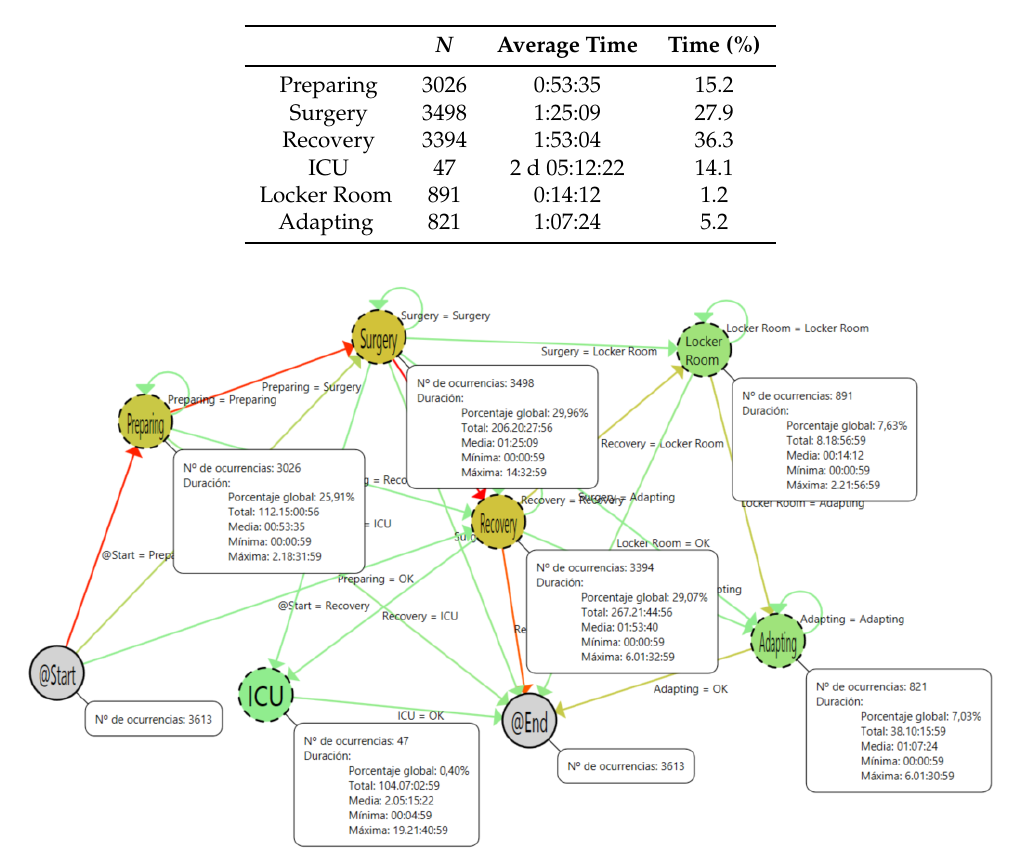
Figure 8. Process with all samples and fixed tool